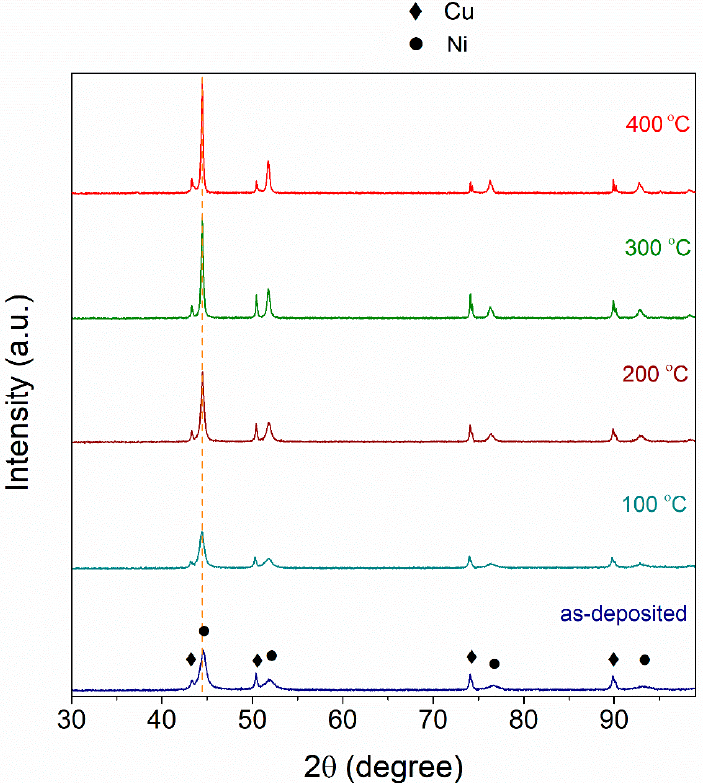
Figure 1. X-ray diffractograms for Ni coatings (as-deposited coating and 100 ◦ C–400 ◦ C—heat treated temperature) obtained in a plating bath composed of ChCl and EG (1:2 molar ratio) and 1 mol dm − 3